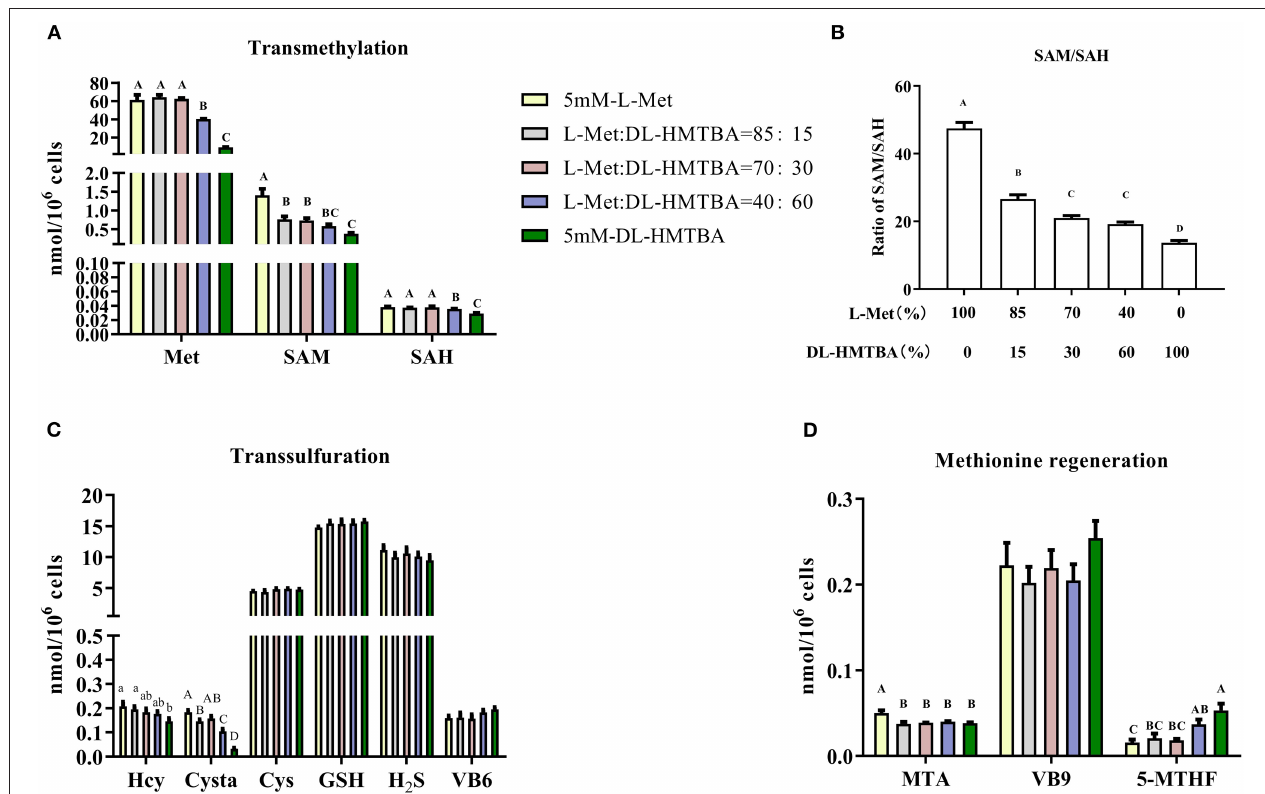
FIGURE 2 | Effects of different ratios of L-Met and DL–HMTBA on the changes of methionine metabolites and coenzyme in IPEC-J2 cells. (A) Transmethylation-related metabolites; (B) Ratio of SAM to SAH; (C) Transsulfuration-related metabolites; (D) Methionine regeneration related substances Cells were cultured without fetal bovine serum for 18h and then without Met for 6h, then, different ratios of L-Met and DL–HMTBA were given for 2h (total methionine source concentration is 5mM). Metabolic pathways are shown in Supplementary Figure 4 . Values are means ± SEM, n = 3; different letters (A–D) mean the difference is extremely significant, p < 0.01; different letters (a,b) mean the difference is signific, p < 0.05.